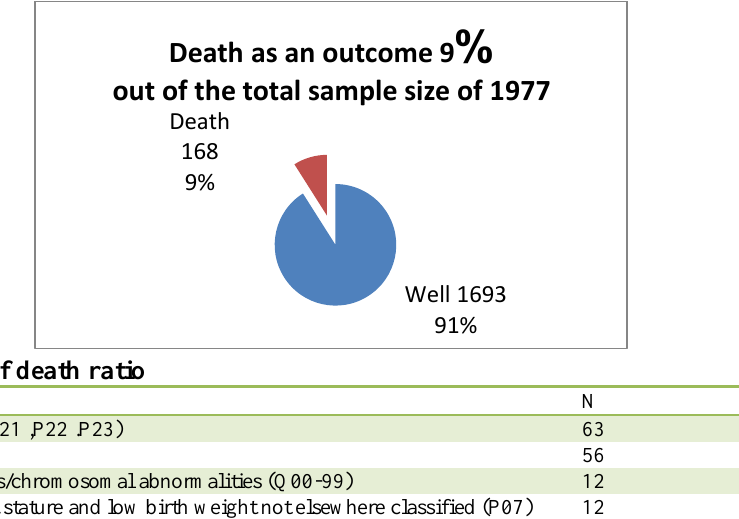
(Table- 3): The case fatality rate in the total sample.